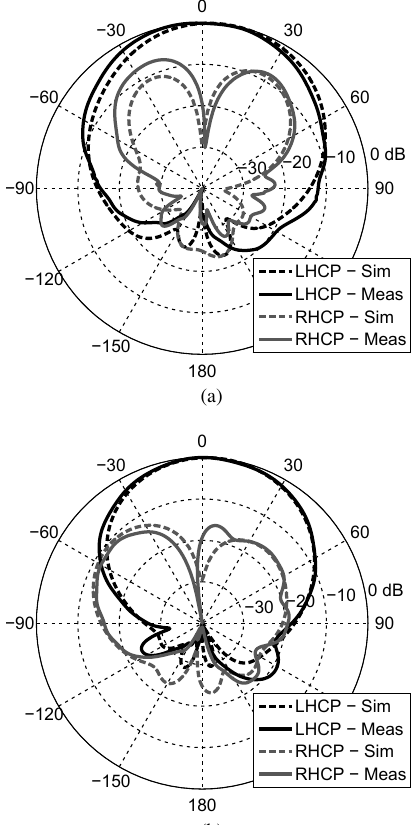
FIGURE 24. Simulated and measured pattern results for the CP Reconfigurable E-shaped patch element. (a) ϕ = 0 ◦ cut at 2.45 GHz. (b) ϕ = 90 ◦ cut at 2.45 GHz. Measurements showed a peak directivity of 8.35 dB. Adapted from [17]. E-shaped patch antenna.